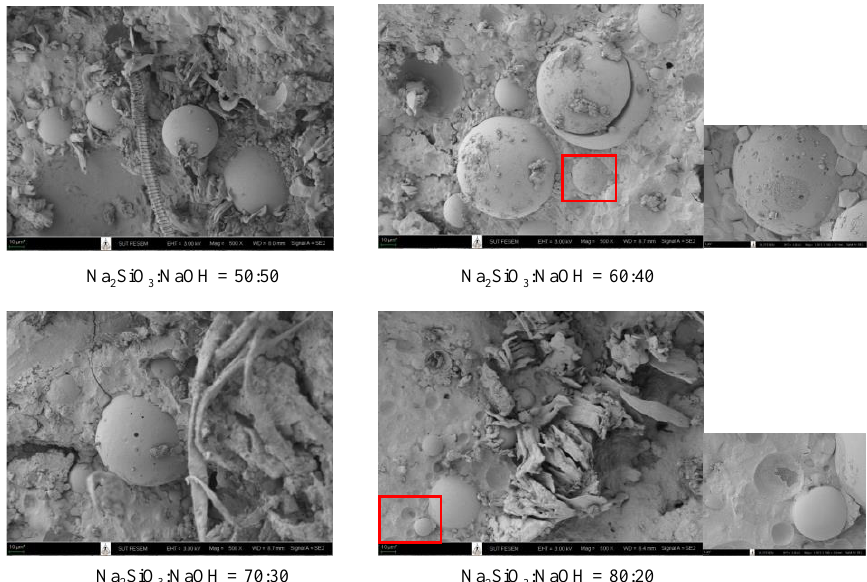
Figure 6. 7-d SEM images of RCA-FAG samples at RCA:FA = 80:20 and Na 2 SiO 3 :NaOH = 50:50,